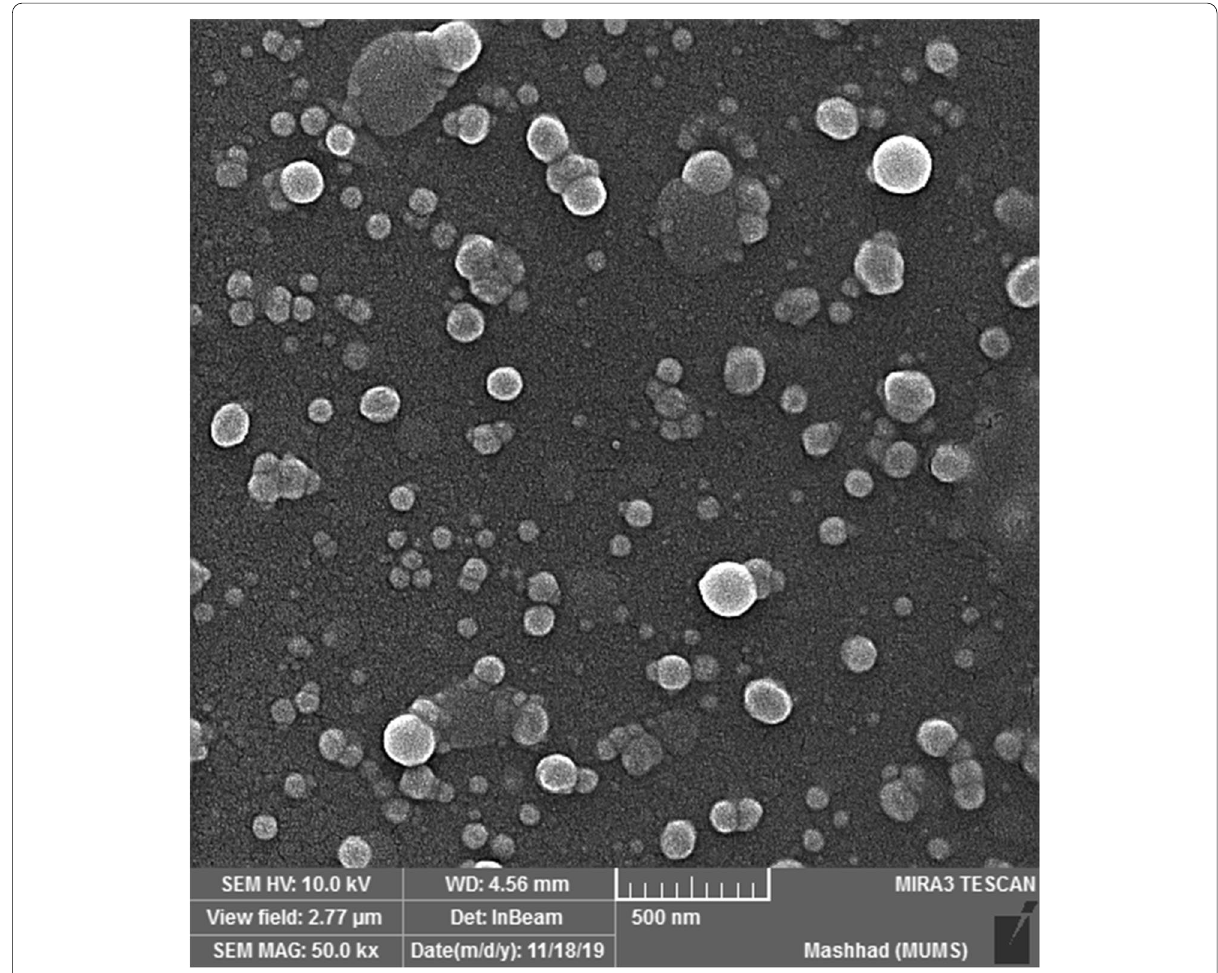
Fig. 1 The FESEM analysis of nanoliposome-loaded phenolic-rich fraction from A. rosea